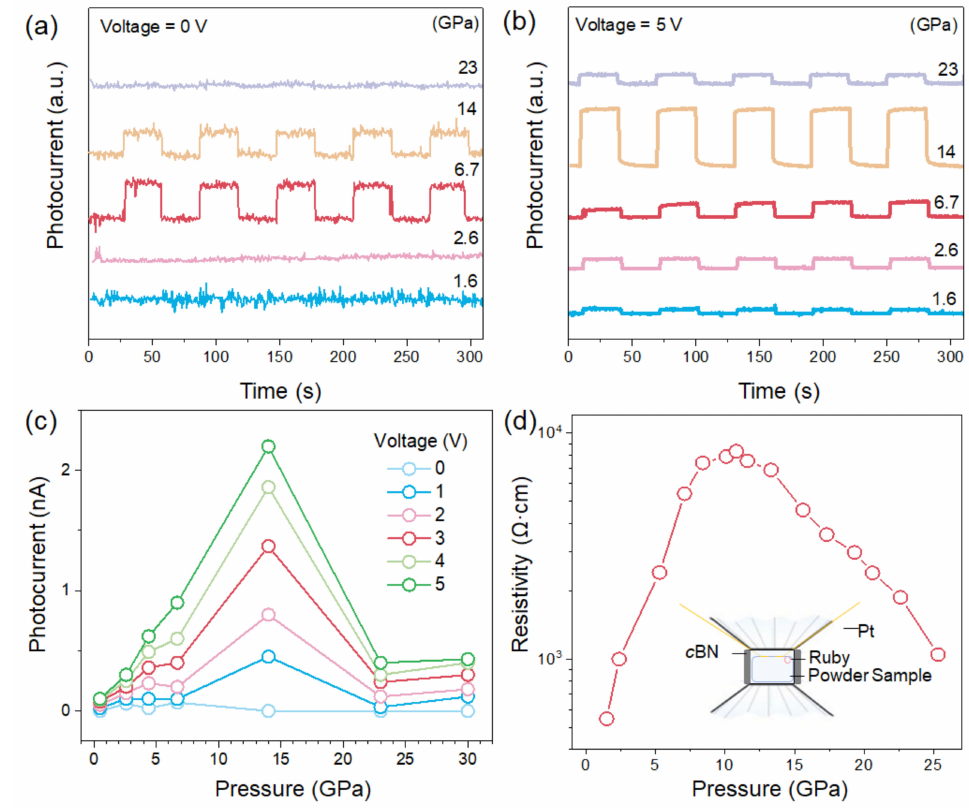
Figure 3. Photocurrent and resistivity of SbSI at different pressures. ( a , b ) Pressure-dependent photocurrent of SbSI at 0 and 5 V bias voltages. ( c ) Photocurrent as a function of pressure at different bias voltages. ( d ) The resistivity of SbSI under high pressures. The inset shows the schematic diagram for resistivity